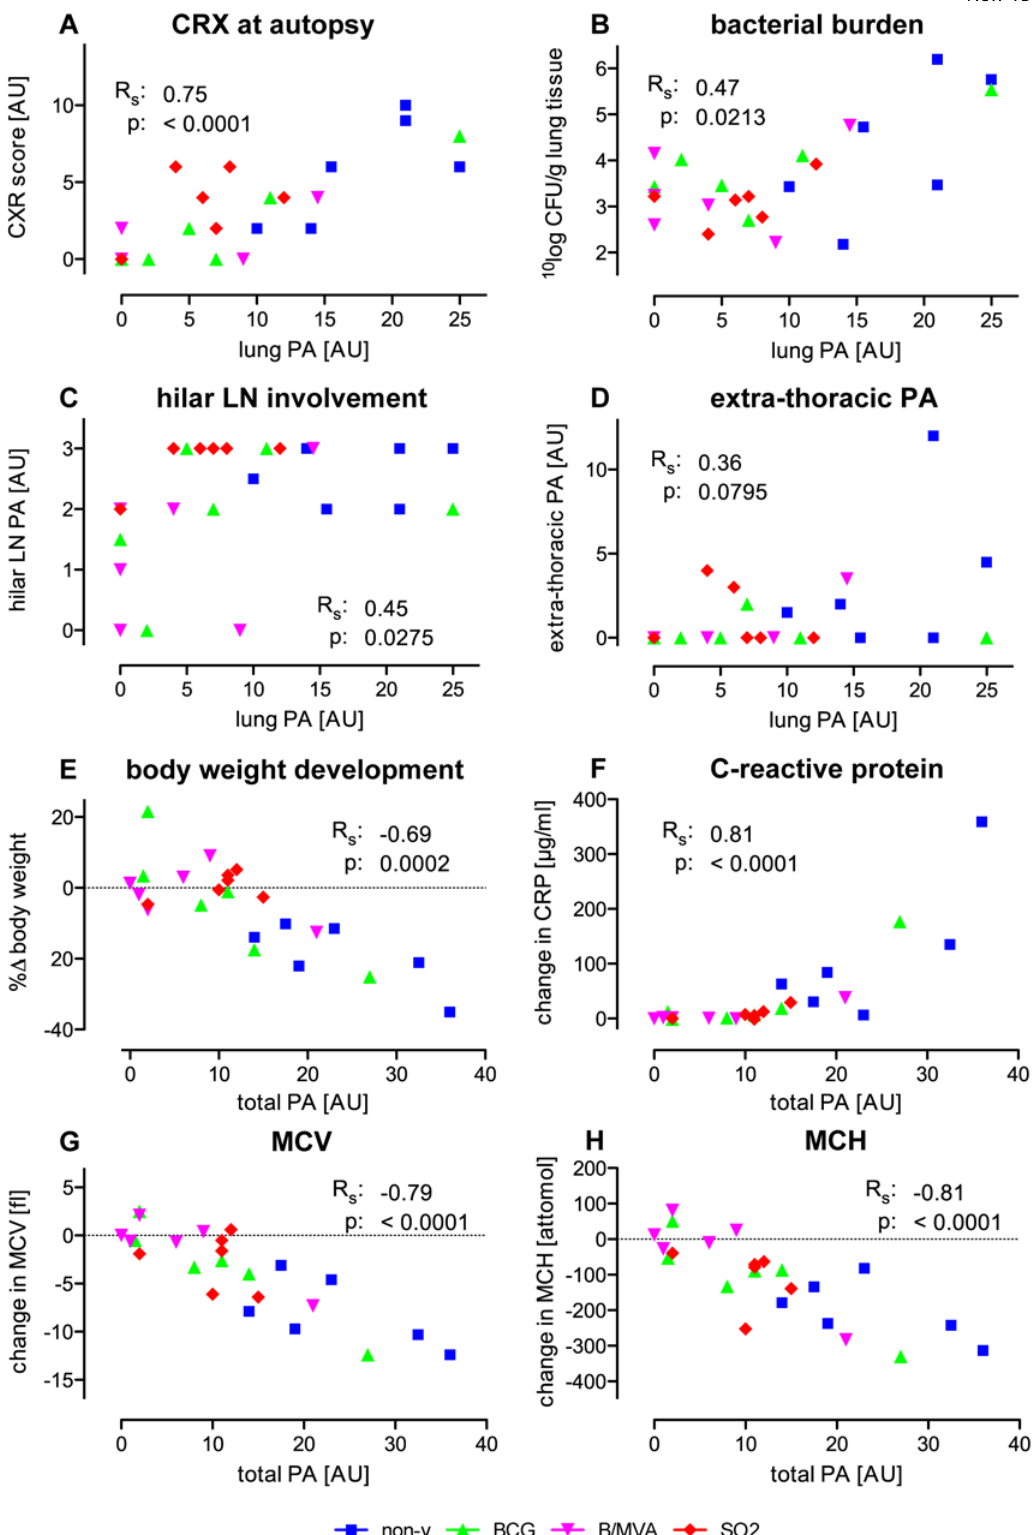
Figure 4. Correlations of disease along the infection phase. Thorax radiology, bacterial burden, and hilar LN pathology correlate significantly with lung PA. Loss of total body weight (wasting), and C-reactive protein (CRP) levels and decreasing mean corpuscular volume (MCV) and mean corpuscular hemoglobin (MCH) as measures of systemic inflammation, are highly significant correlates of disease in this high dose challenge model for TB vaccine evaluation. Parameters are plotted per individual (with colouring as indicated in the legend to Figure 2 on group colouring) against lung PA for CXR scores at autopsy (A), CFU counts from lung homogenates (B), hilar LN involvement (C), disseminated extra-thoracic lesions (D), and against total pathology (the sum of lung, hilar LN and extra-thoracic PA scores) for relative change in body weight (E), change in CRP (F), change in MCV (G) and in MCH (H). Spearman’s rho (R s ) as correlation factor and p-value are indicated. (AU for arbitrary units.)